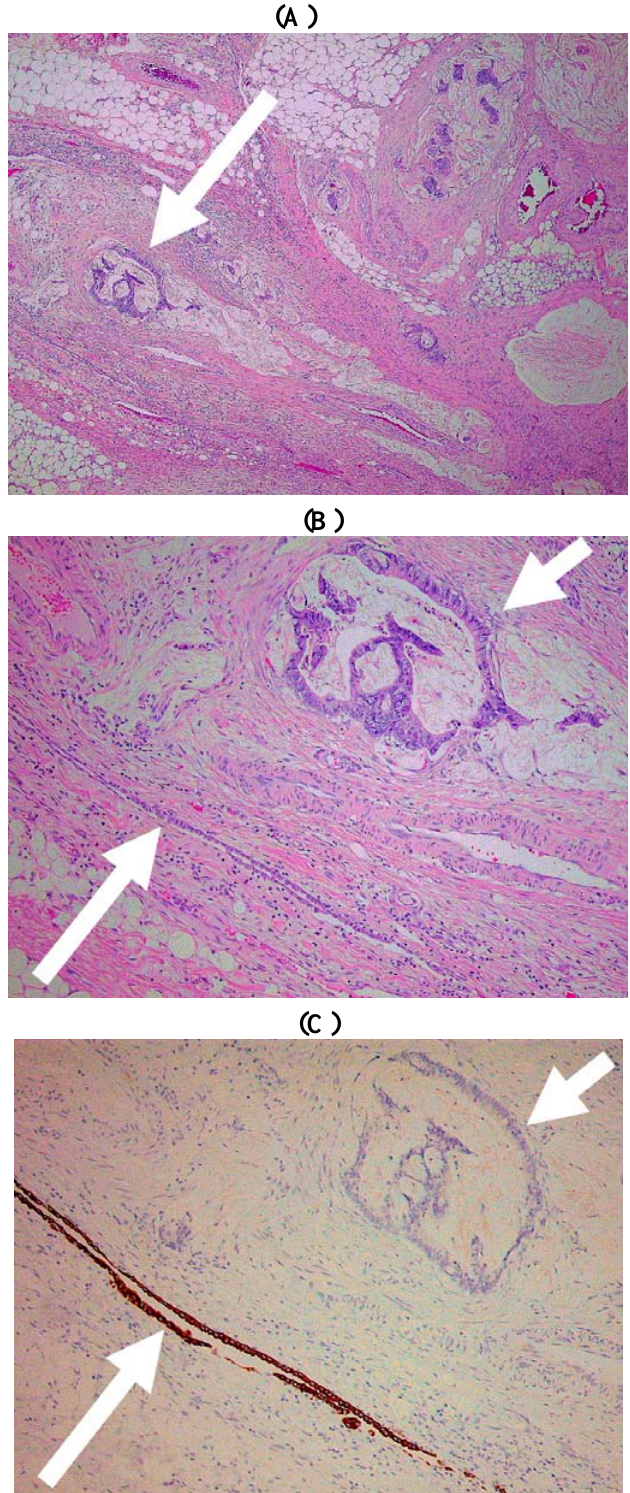
Figure 5. Histological image of colorectal carcinoma infiltrating the subserosal fat. ( A ) At low magnification there is no obvious relationship between the tumor and the serosal surface but note arrowed focus of malignant glands (×40). ( B ) At higher magnification the same tumor focus (short arrow) is adjacent to an inconspicuous serosal cleft lined by mesothelium (long arrow) (×100). ( C ) The mesothelium is highlighted by immunohistochemical staining for cytokeratin 7